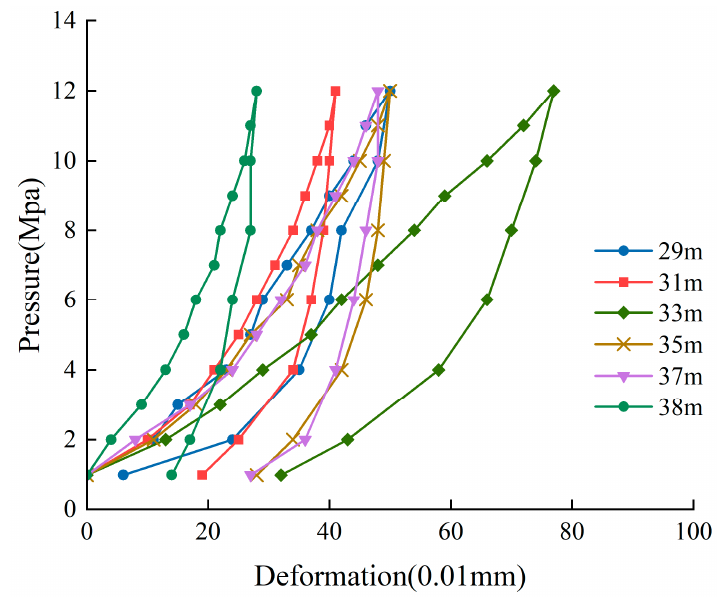
Figure 5. NS-ZK-6 borehole pressure deformation curve.